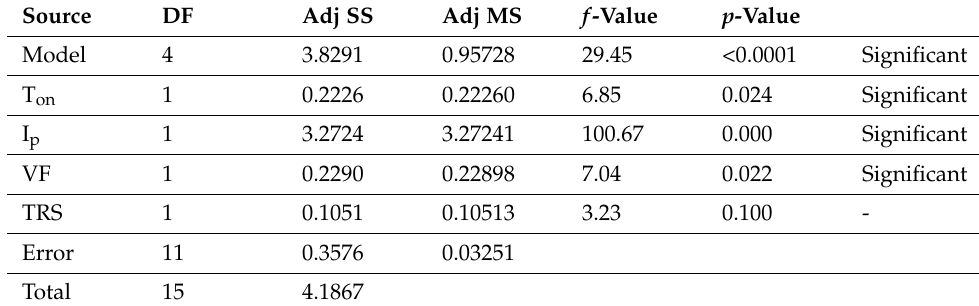
Table 6. The ANOVA for the R a